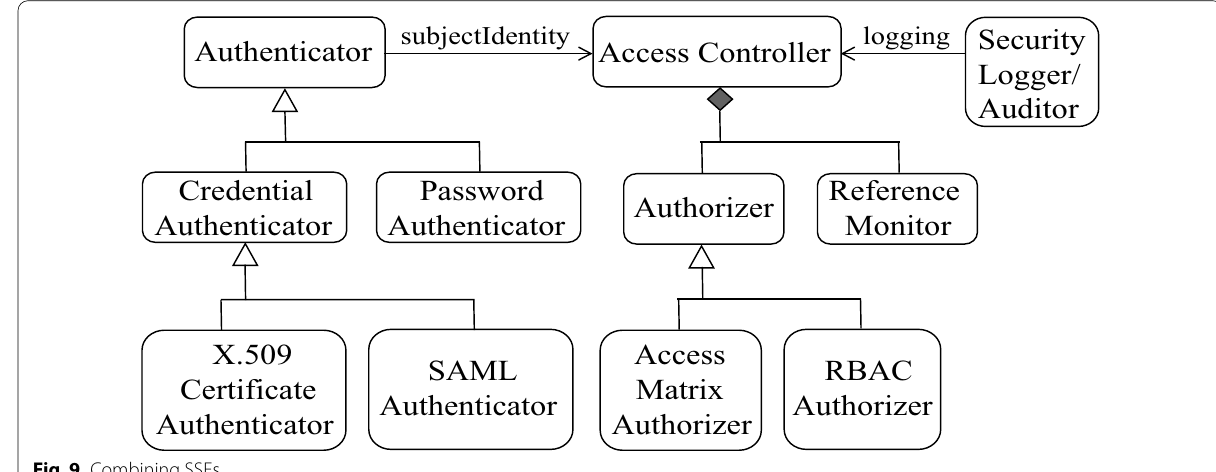
Fig. 9 Combining SSFs